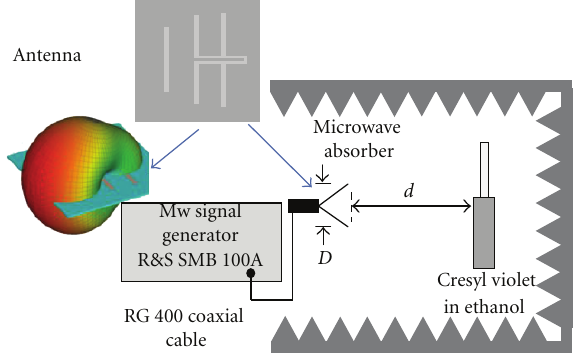
Figure 2: microwave irradiation set up, antenna configuration (front and back), and antenna radiation pattern.